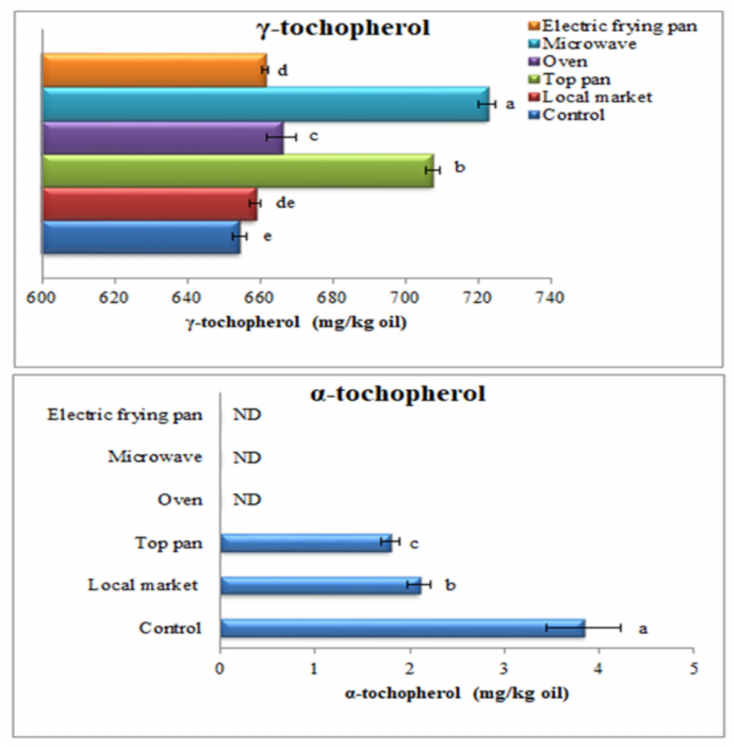
Figure 3. Tocopherol contents in oils recovered from sesame roasted with different methods. Signifi- cant variations at p ≤ 0.05 are indicated by vertical bars with SD (n = 3) and different letters on the bars of every